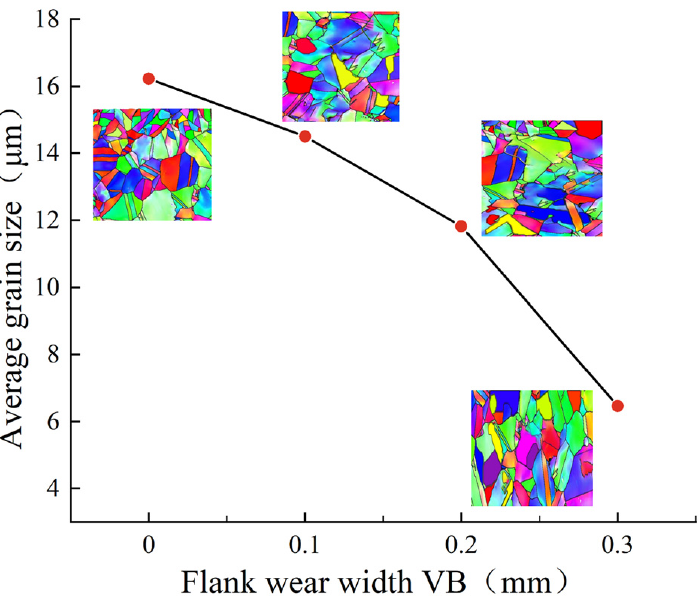
Figure 16. Statistics of the grain morphology and average size in the GH4169 cutting metamorphic layer under different flank wears.